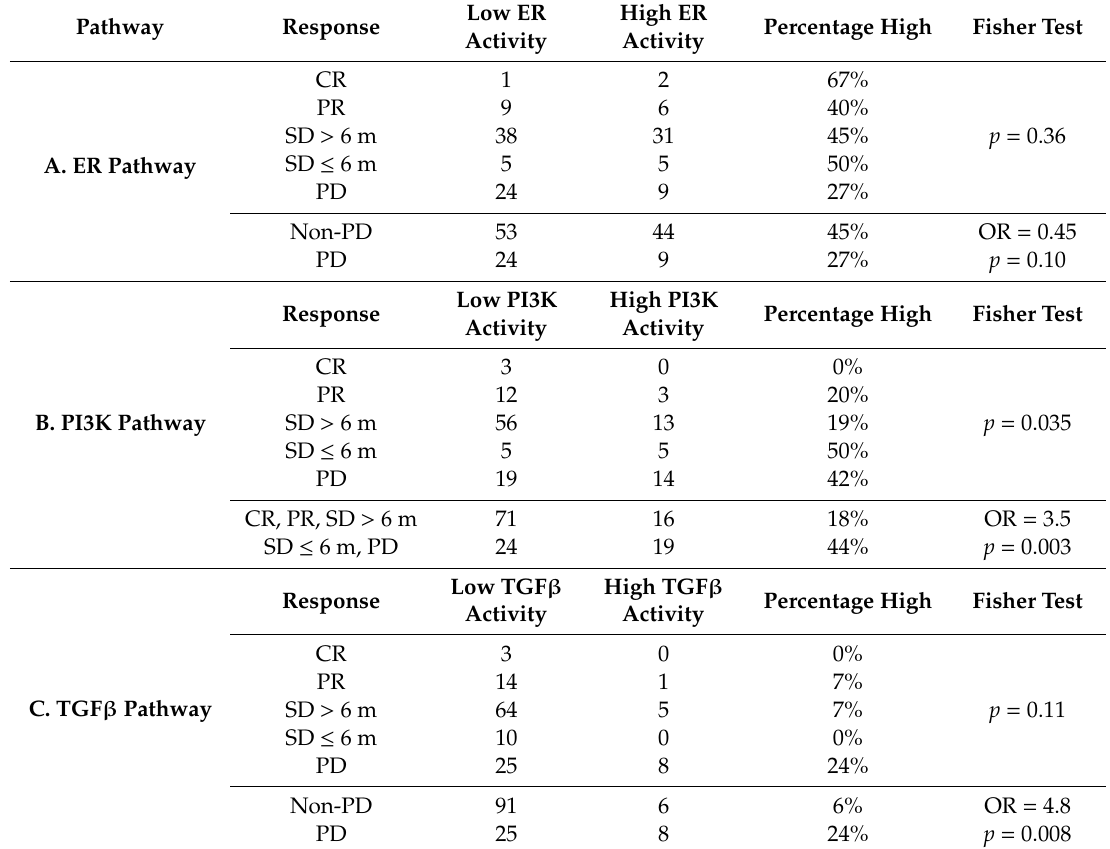
Table 2. Association of pathway activity in primary tumor with response to hormonal therapy in the patients with metastatic